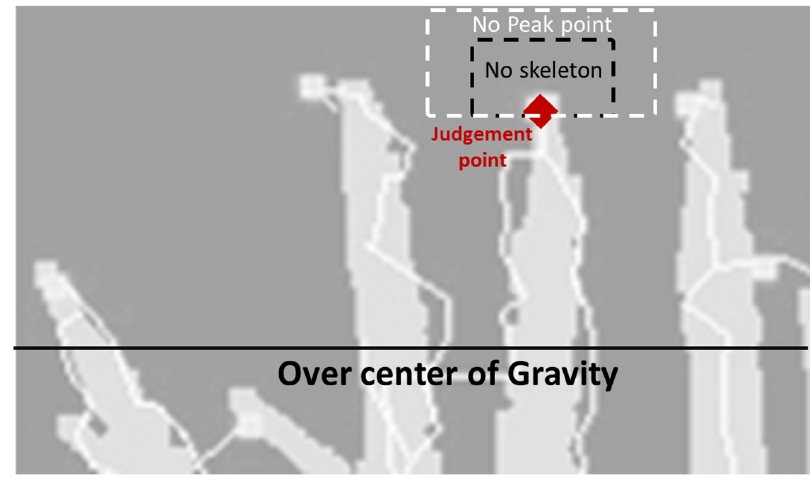
Figure 5. Concept of the peak-in-window method.